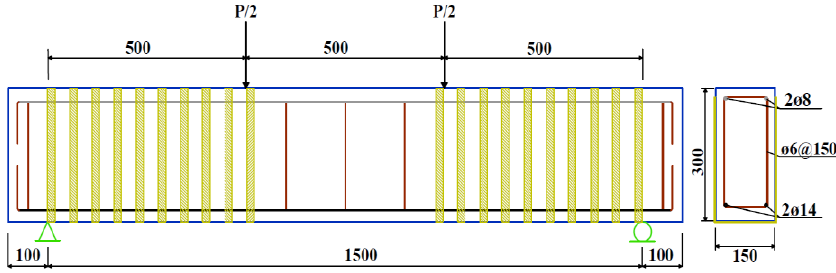
Figure 13. Detailed Geometry of Dong et al. CFRP-Strengthened Specimens (FB30-2 and FB30-3) [7].